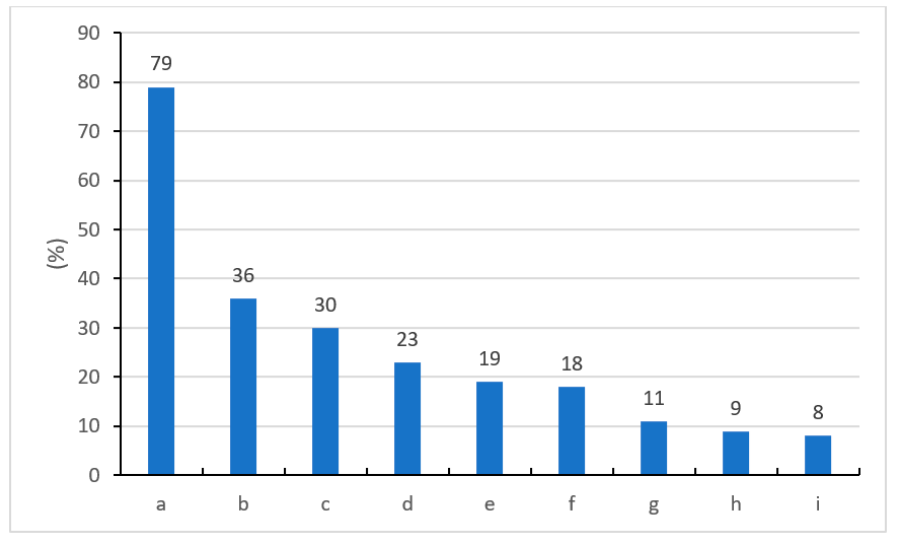
Figure 6. Attitudes towards the event of Croatia’s accession to the EU and its fully-fledged membership.